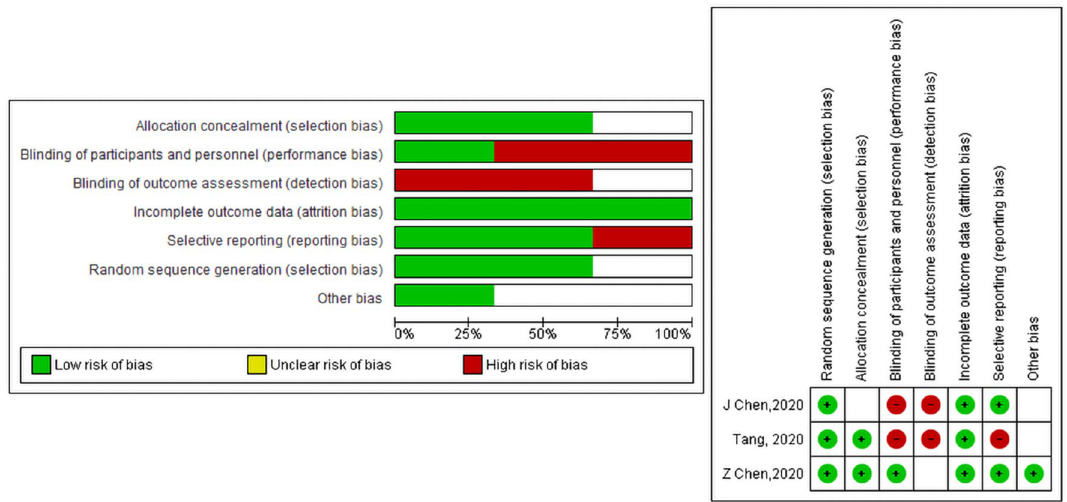
Figure 2. ( a ) Risk of bias graph: review authors’ judgements about each risk of bias item presented as percentages across all included studies. ( b ) Risk of bias summary: review authors’ judgements about each risk of bias item for each included